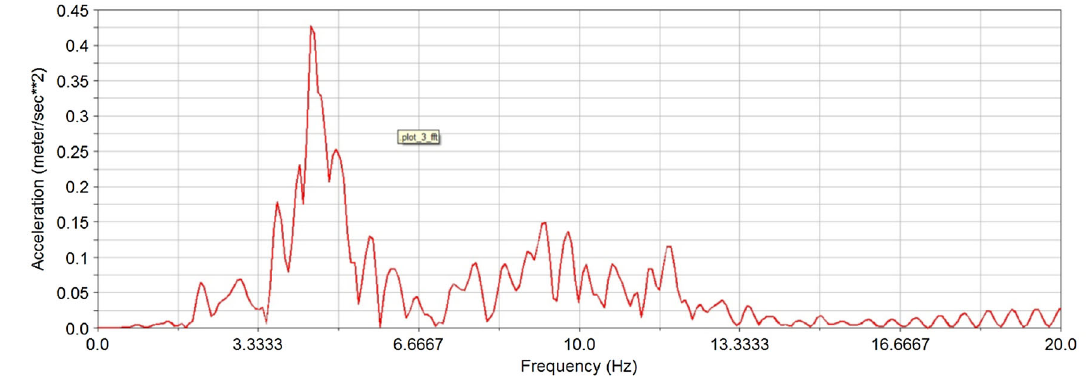
Fig. 5 FFT transformation results of vertical acceleration of front bogie front axle Fig. 6 Data of the vertical vibration acceleration of the center point of the front bogie front axle in the middle vertical. a Time-domain vibration, b data after